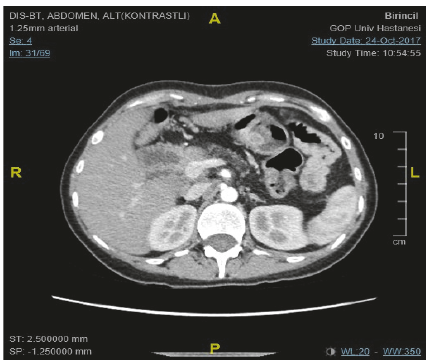
Figure 3: Contrast-enhanced computed tomography 7 months after Whipple procedure. No residual tumor can be